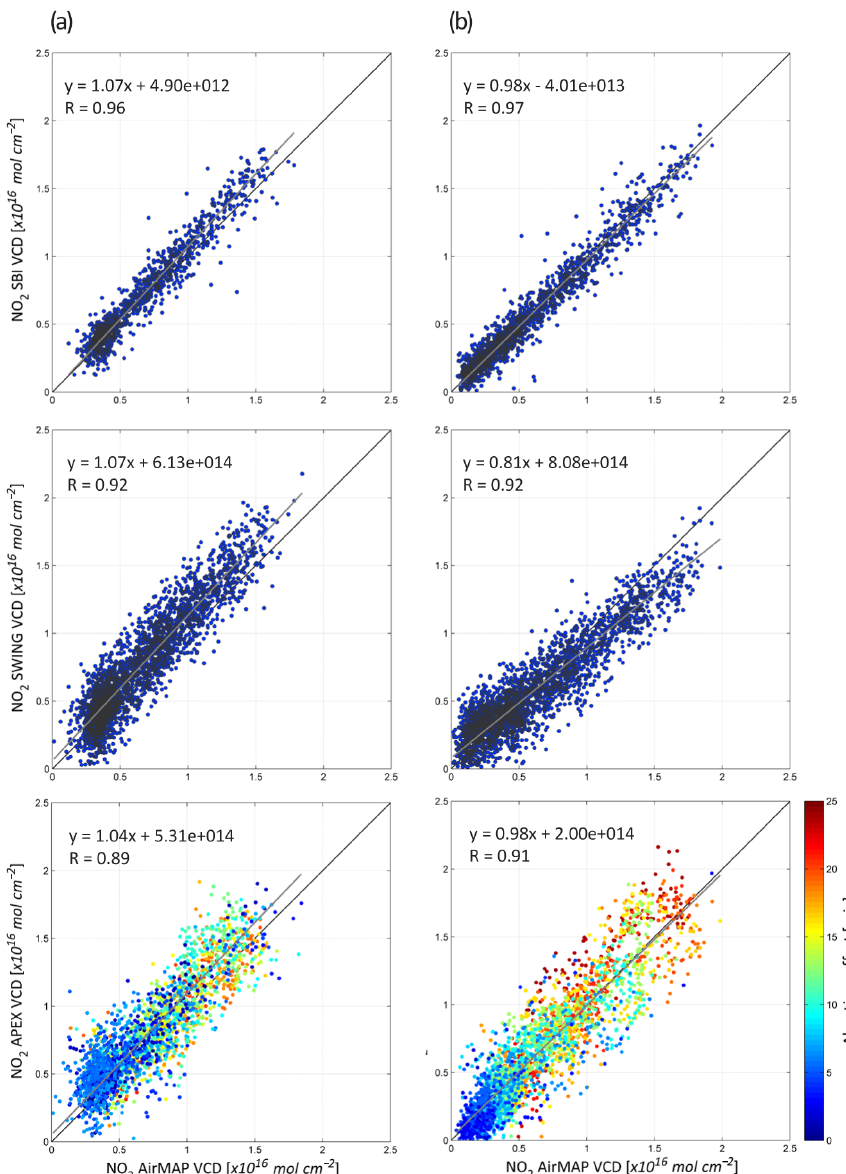
Figure 19. Scatter plots and orthogonal linear regression analyses of the co-located NO 2 VCDs, retrieved from the harmonised maps for respectively (a) the morning and (b) afternoon flights on 21 April 2016. The AirMAP NO 2 VCDs are plotted on the x axis. The black solid line and grey line represent the 1 : 1 ratio and the linear regression, respectively. The colour-coding in the lower plots indicates the absolute time offset between the observations from the two aircraft. Note that the same data points are plotted as in the time series plots of Fig.